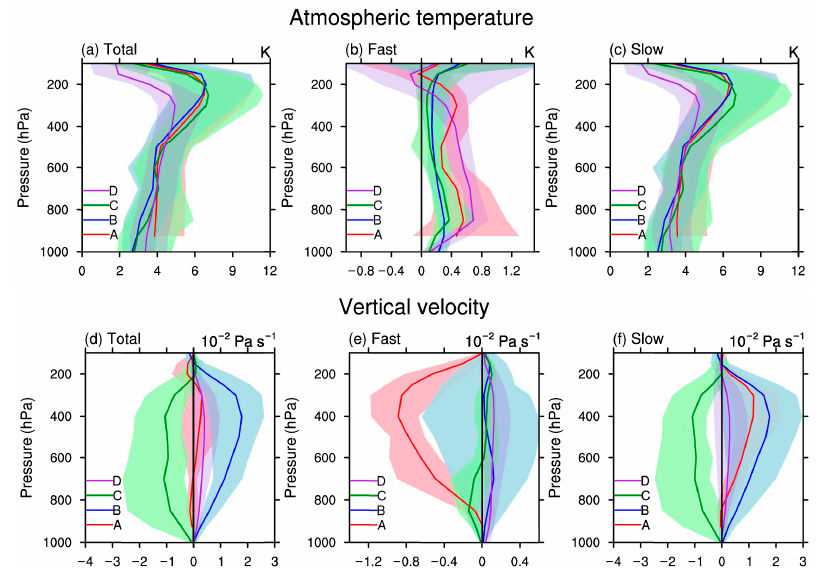
Figure 12. ( a , d ) Total, ( b , e ) fast, and ( c , f ) slow responses of ( a–c ) atmospheric temperature (unit: K) and ( d–f ) vertical velocity (unit: 10 − 2 Pa s − 1 ) in four typical regions. The red, blue, green, and purple lines represent regions A, B, C, and D, respectively.